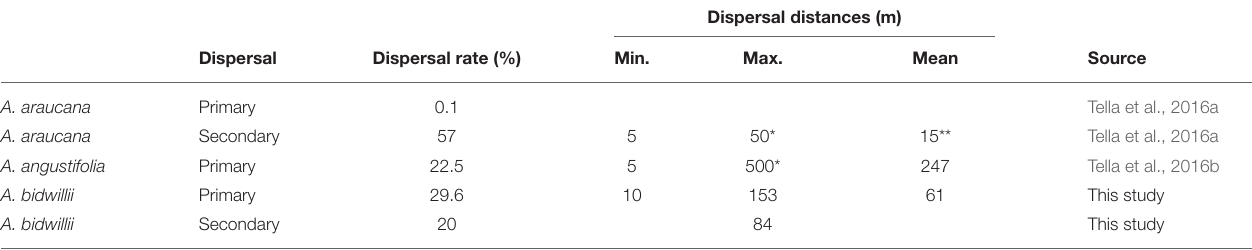
Dispersal distances (m)